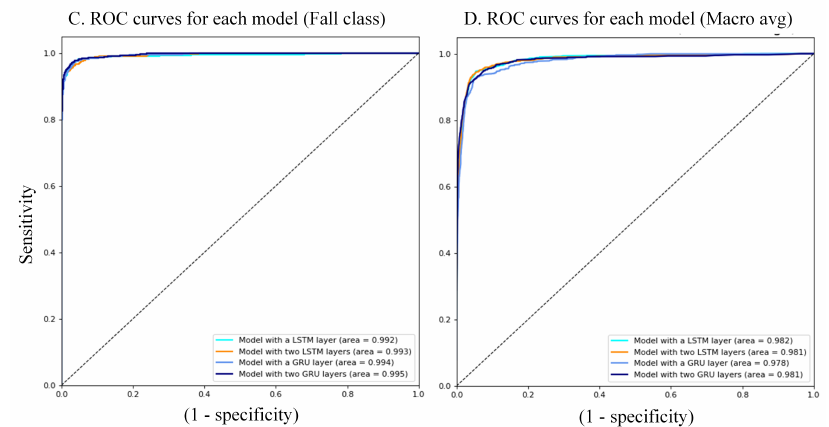
Figure 5. Receiver operating characteristic (ROC) curves of the best models for each architecture considered (at 25 Hz).